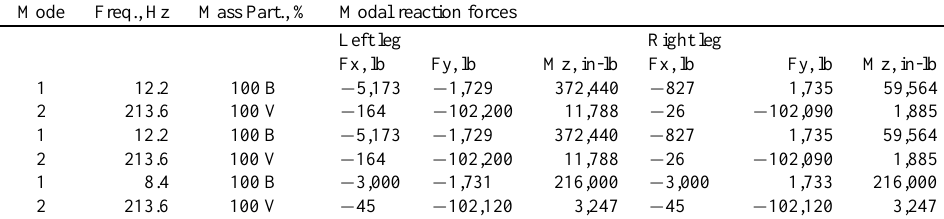
Table 5 Shock analysis results for other cases; Asymmetric structure